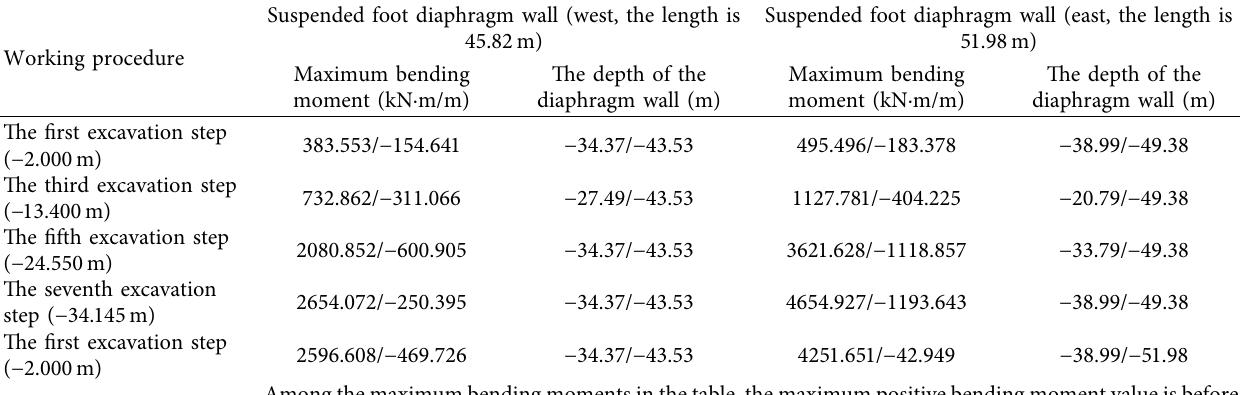
Table 8: Summary of the corresponding depth of the maximum bending moment of the suspended foot connecting wall. Working